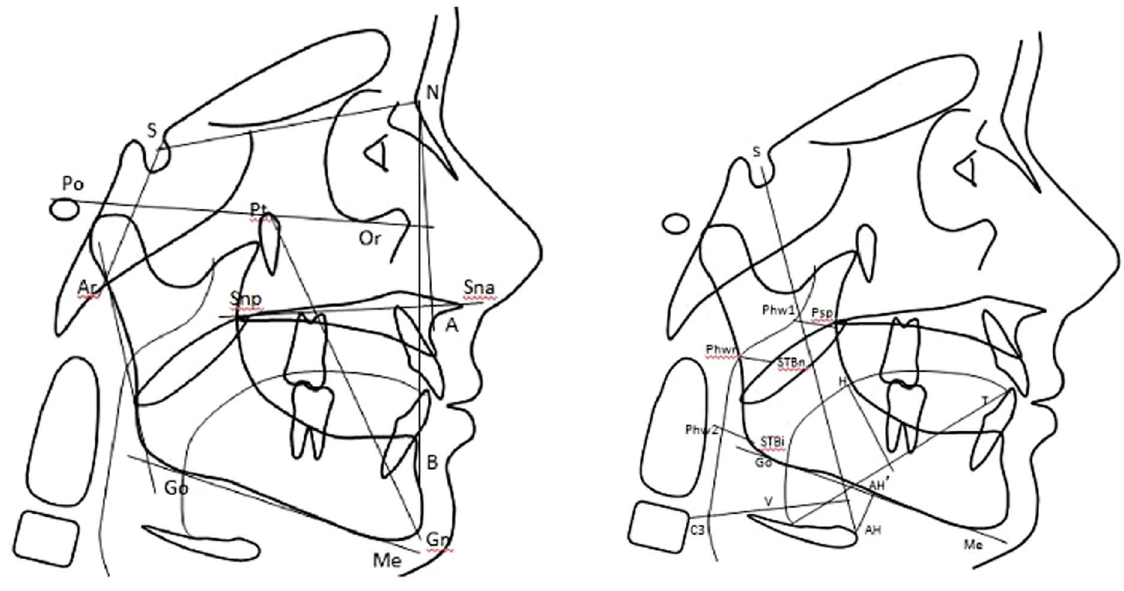
Figure 1. SNA (degrees), SNB (degrees), and ANB (degrees) were used to define the maxillary and jaw position with respect to the cranial base (SN) and the respective skeletal Class; NS ‘ Ar (degrees), SAr ‘ Go (degrees), ArGo ‘ Me (degrees) study growth direction; BaN ‘ PtGn is the upper angle, measured between total cranic base (BaN) and facial axis (Pt Gn) and defines the facial growth; Po- Or ‘ GoMe or FMA (degrees) is measured between the Frankfort horizontal plane and the mandibular plane and represents the total divergence while PFH ‘ SnaSnp the superior divergence and SnaSnp ‘ GoMe, the inferior divergence. AH-C3H (mm), the horizontal distance from AH to C3; AH-AH’ (mm), the vertical position of the hyoid to the mandibular plane; H VT, representing the vertical position of the tongue; Phw1-Psp (mm), posterior superior airway space; PhwN-STBn, the middle pharyngeal width; PhwI-STBi, inferior airway space.